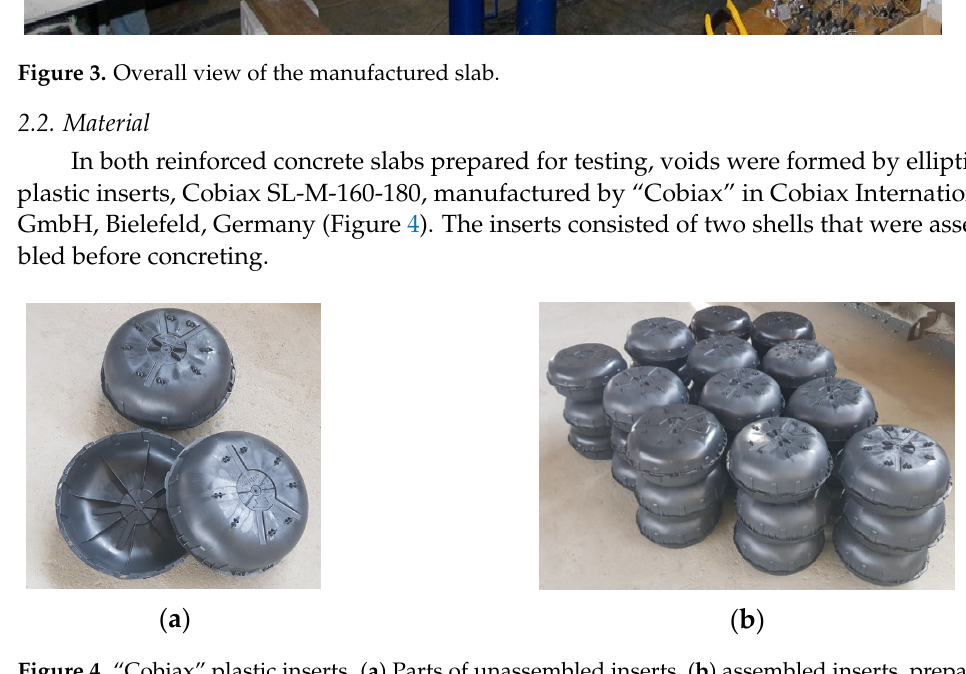
Figure 4. “Cobiax” plastic inserts. ( a ) Parts of unassembled inserts, ( b ) assembled inserts, prepared for concreting.